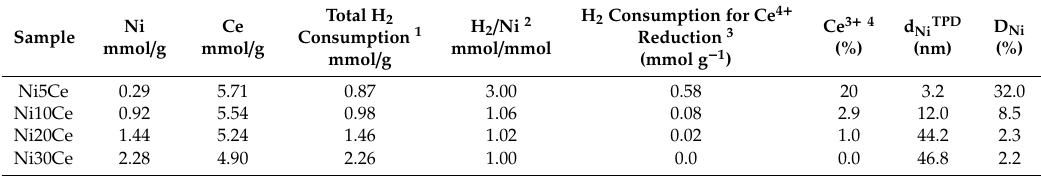
Table 2. Cerium reducibility and nickel